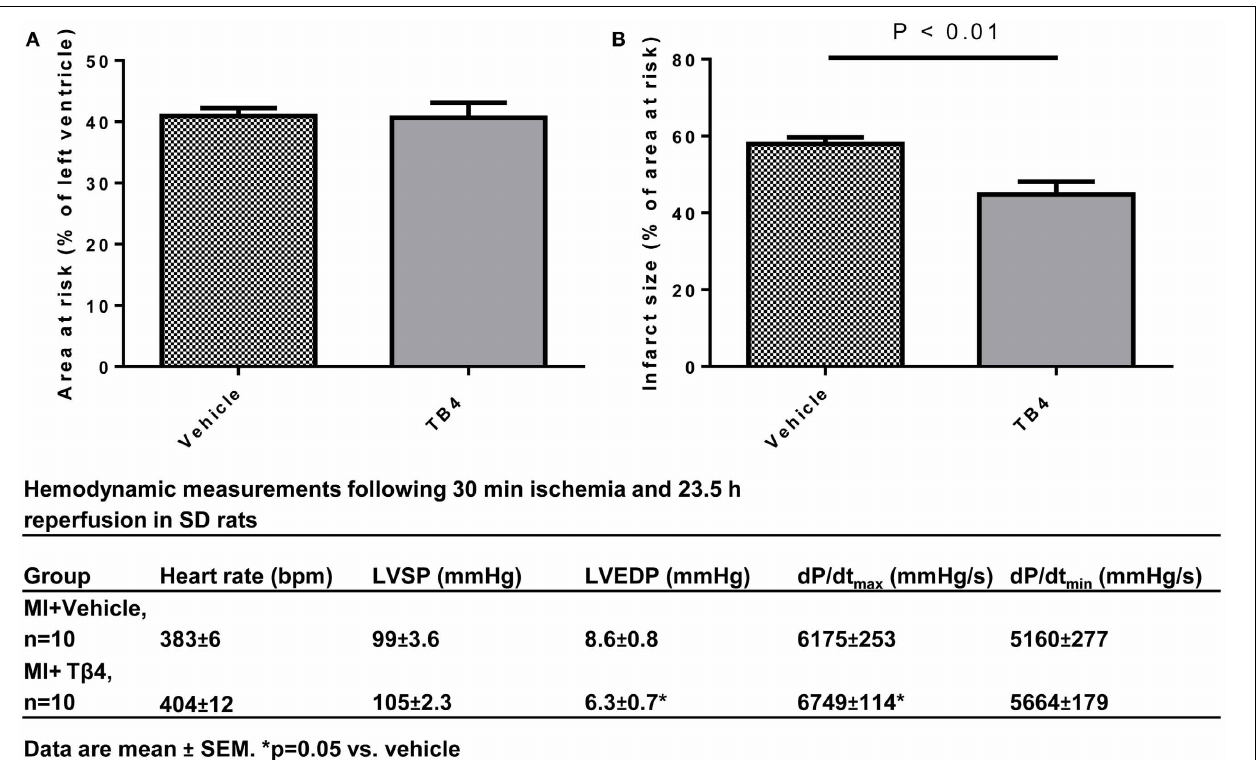
FIGURE 6 | T β 4 treatment reduced infarct size in a rat ischemia-reperfusion model of myocardial injury. (A) Quantification of area-at-risk and infarct sizes in the hearts from rats treated with vehicle vs. rats treated with T β 4 administered both during and after the ischemic period. Acute treatment with T β 4 did not affect the